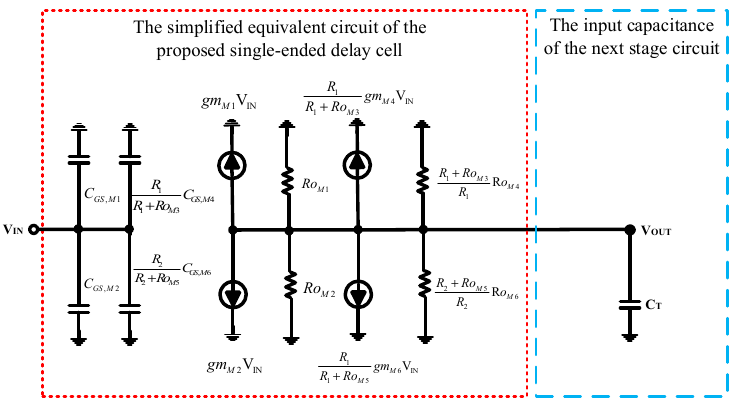
Figure 4. The simplified equivalent circuit of the proposed single-ended delay cell.